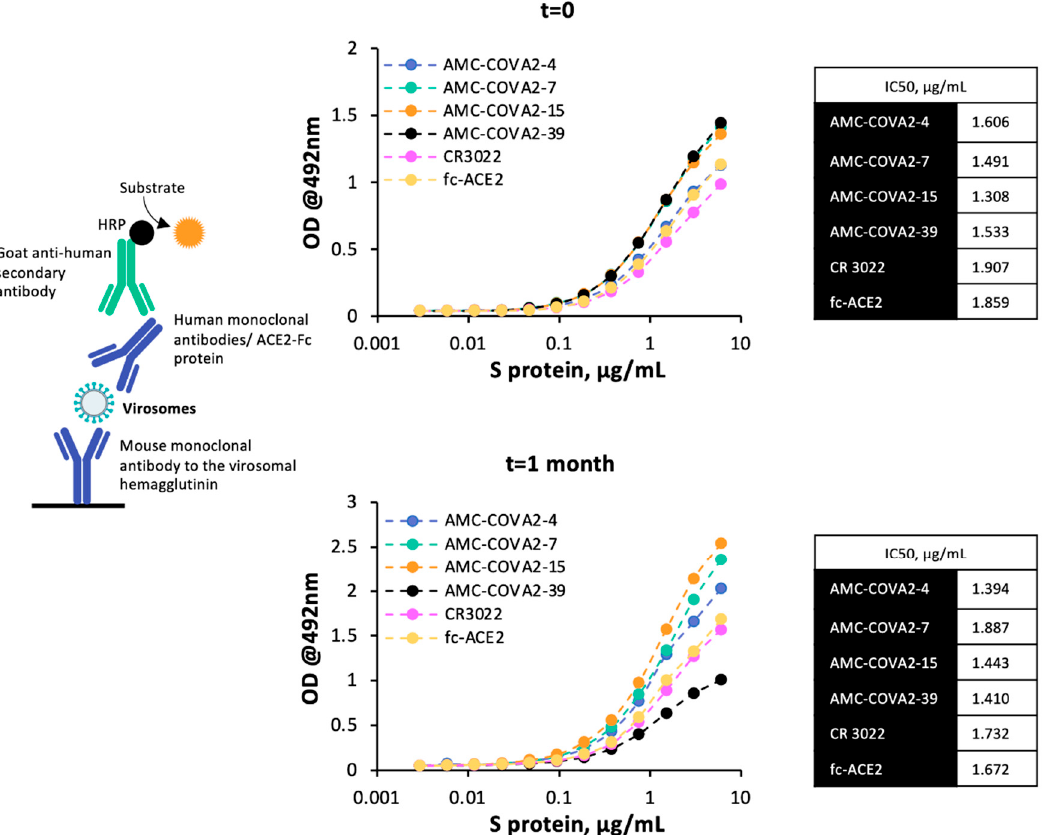
Figure 4. Binding of antibodies to S protein presented on virosomes. Virosomes bound to ELISA plates coated with anti-hemagglutinin were incubated with non-overlapping human neutralizing antibodies recognizing epitopes in the receptor binding domain of S, or with an ACE2-Fc chimera and developed with goat anti-human HRP; panel A at production of virosomes, panel B one month after storage at 4 °C.